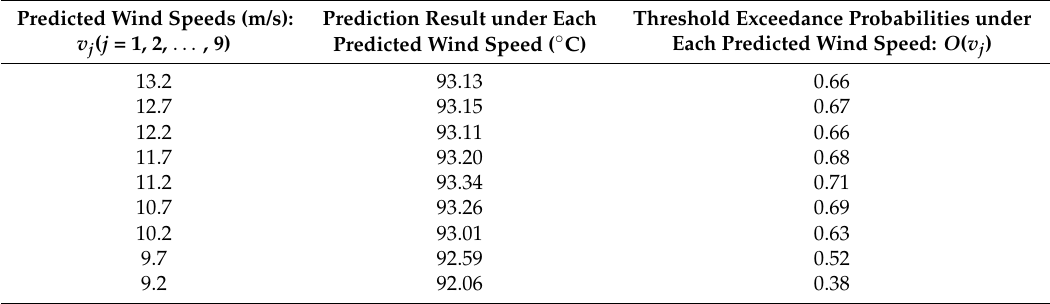
Table 7. The threshold exceedance probabilities for generator bearing b temperature under each predicted wind speed.